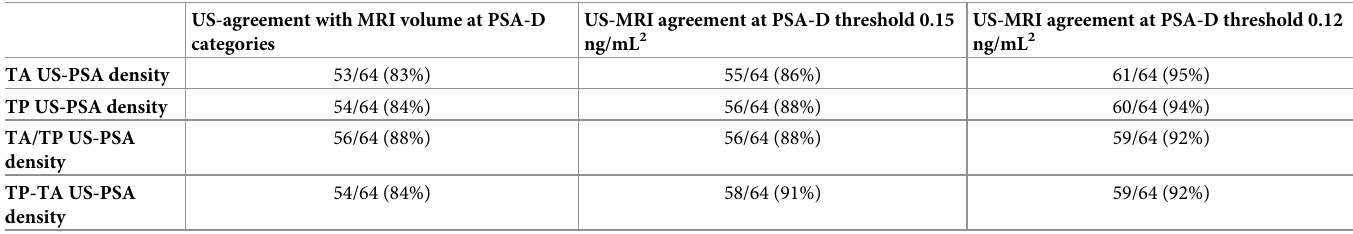
Table 5. Categorical comparison of MRI and US-derived PSA-density (PSA-D) at different biopsy thresholds of < 0.15 ng/mL 2 , 0.15–0.20 ng/mL 2 and > 0.20 ng/ mL 2 ) and agreement to biopsy or not at PSA-density thresholds of 0.15 ng/mL 2 and 0.12 ng/mL 2 . US-agreement with MRI volume at PSA-D